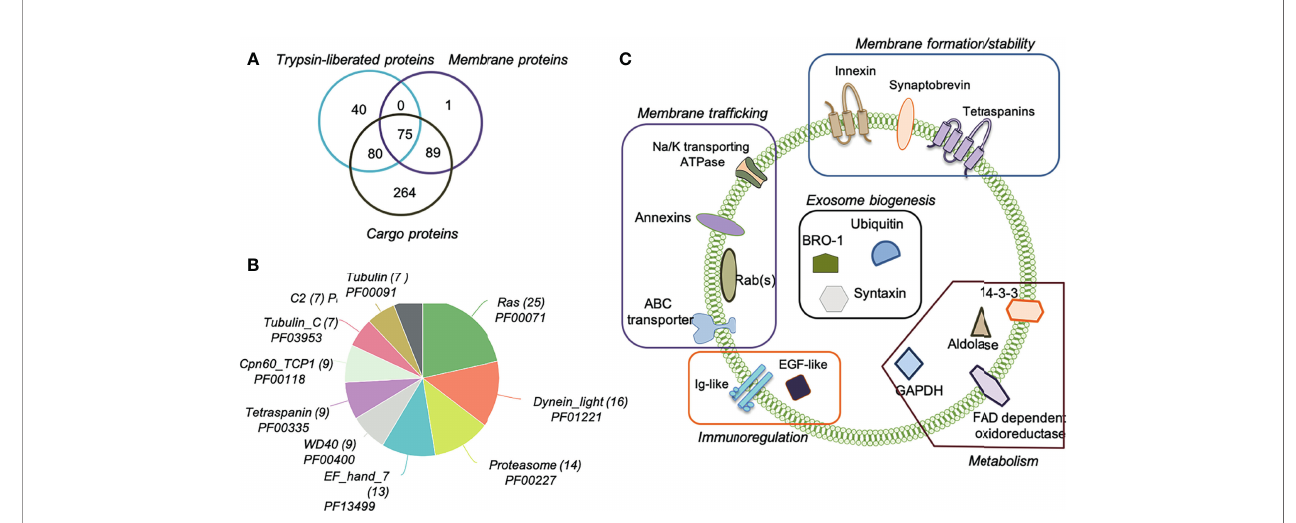
FIGURE 2 | Proteomic analysis of Opisthorchis viverrini 120k extracellular vesicle sub-vesicular compartments. Extracellular vesicles (EVs) were prepared using an Optiprep iodixanol gradient and then subjected to sequential extraction and proteomics analysis to characterise the number of EV proteins identi fi ed by (i) enzymatic shaving (Trypsin-liberated proteins); (ii) membrane proteins remaining after enzymatic shaving, and (iii) intra-vesicular cargo proteins (A) . Most represented Pfam protein families and domains in the identi fi ed proteins were determined (B) . Schematic representation of important proteins present on the surface, anchored in the membrane and within the cargo of O. viverrini 120k EVs (C)